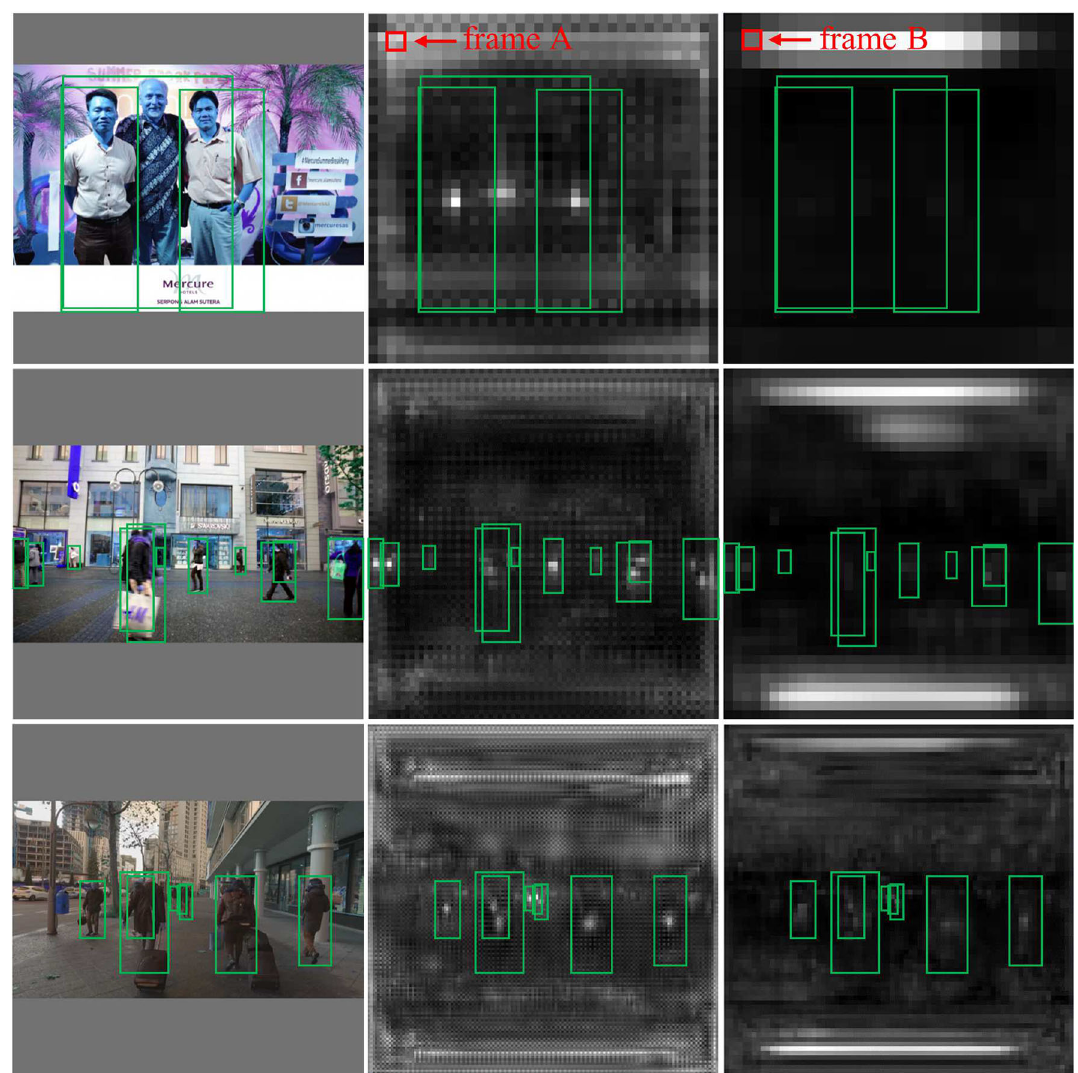
Fig. 9 Visualized results of the ablation studies. From the left column totherightcolumnaretheinputimageslabeledwiththetargetbounding boxes, the visualized pyramid features generated by the SPCS module,